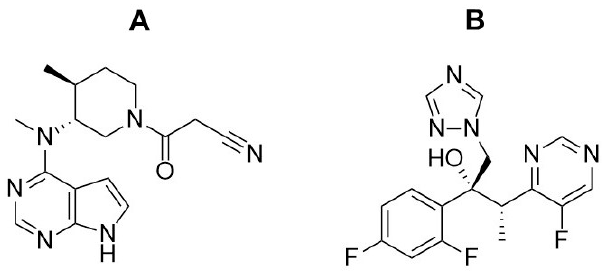
Figure 1. Structures of tofacitinib ( A ) and voriconazole ( B ).